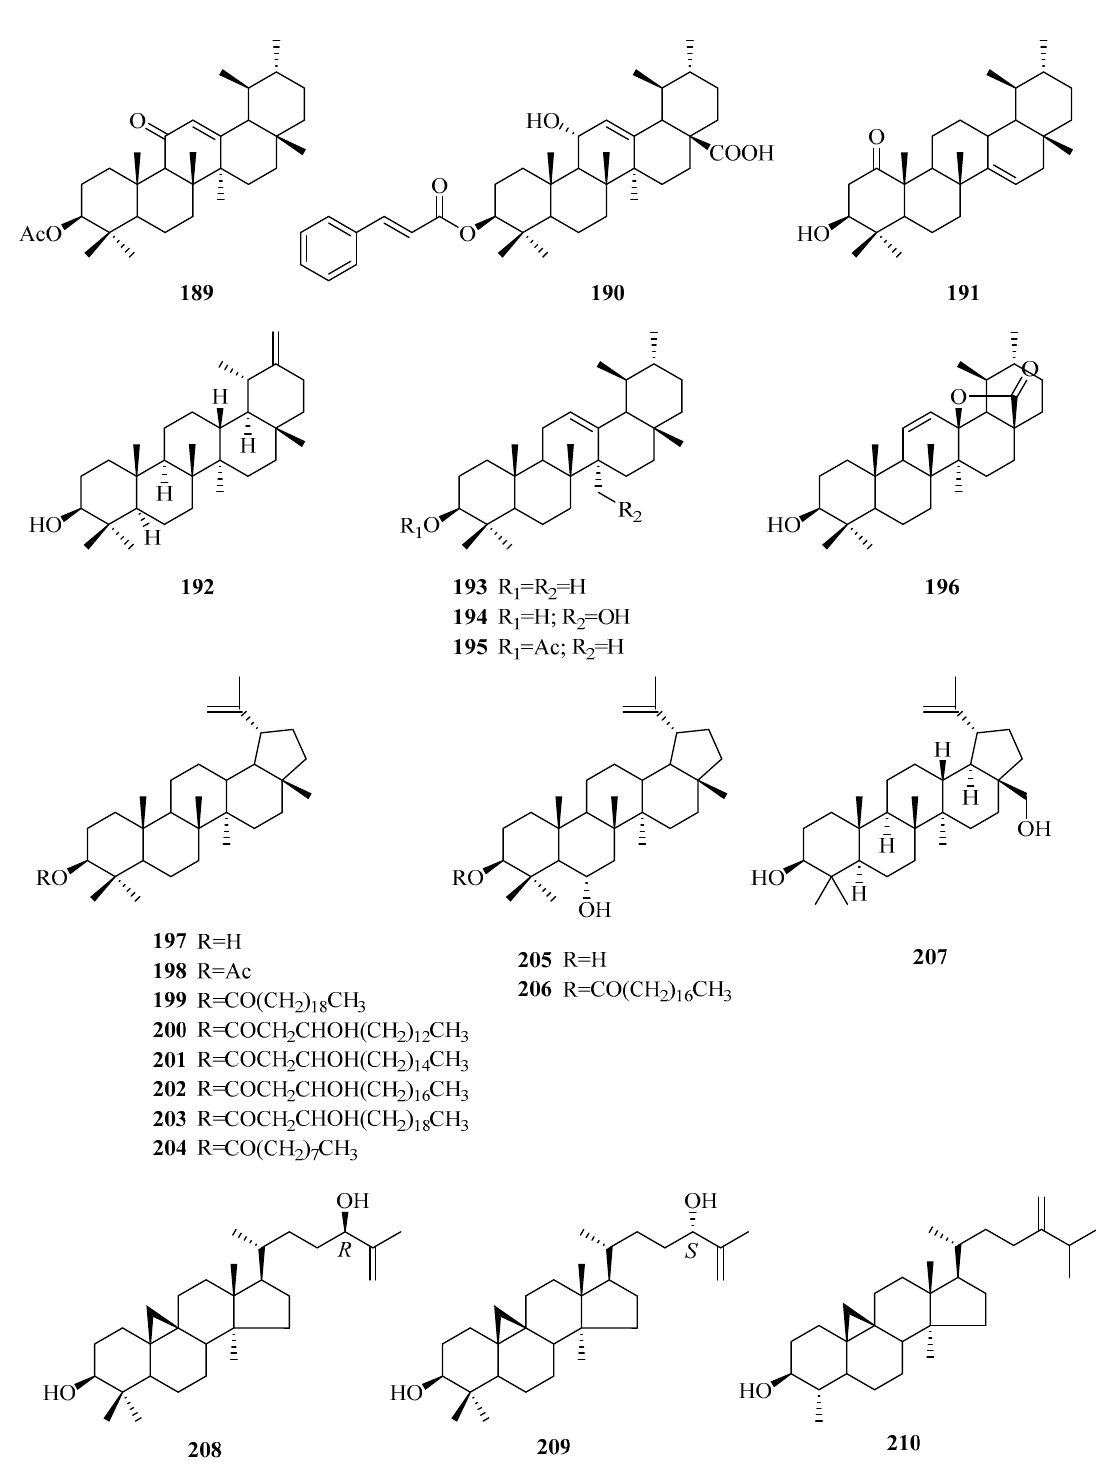
Figure 6. Terpenoids from the genus Periploca .